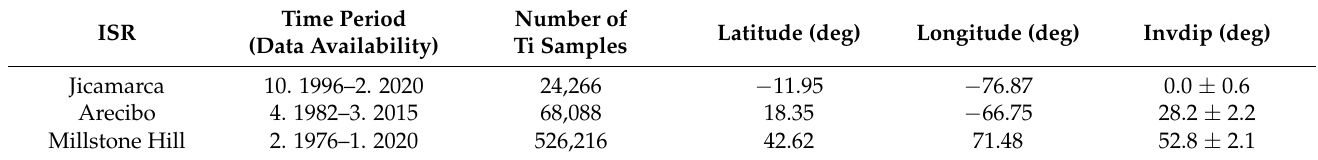
Table 2. Three ISRs and available Ti